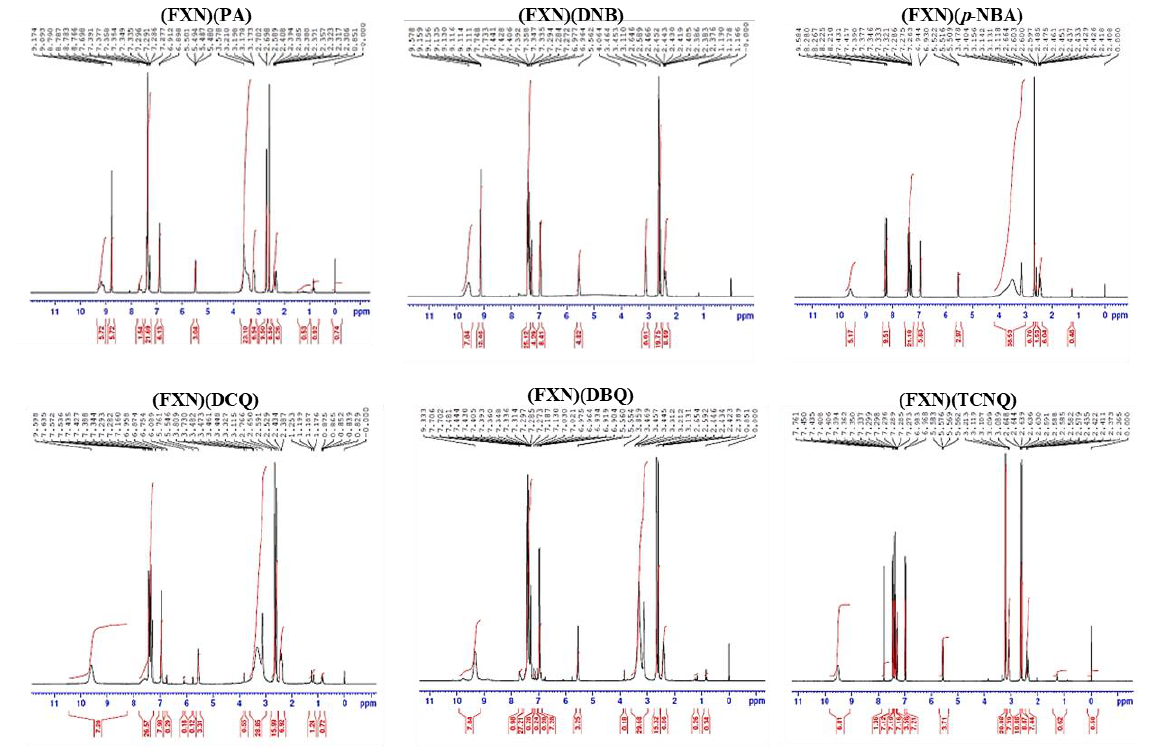
Figure 3. 1 HNMR spectra of the six ligand complexes.